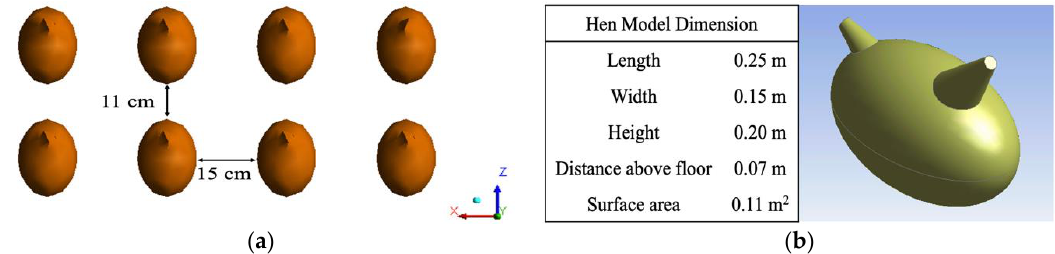
Figure 3. ( a ) Top view of eight evenly distributed hen models; ( b ) dimensions of a single hen model with simplified geometry from isometric view [1]. Reprinted with permission from ref. [1]. 2020. Chen et